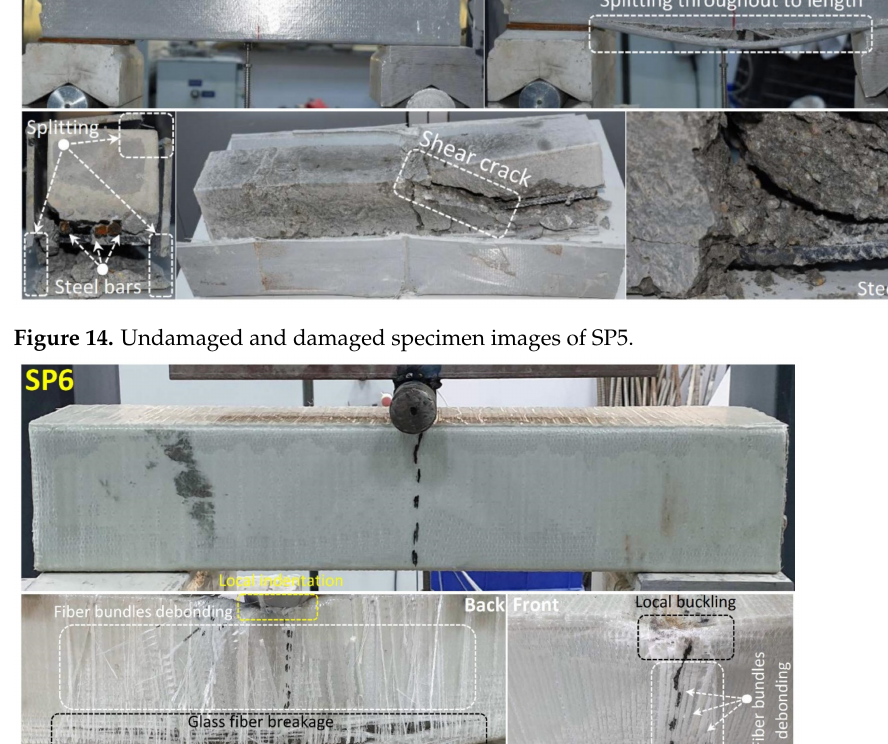
Figure 15. Undamaged and damaged specimen images of SP6.